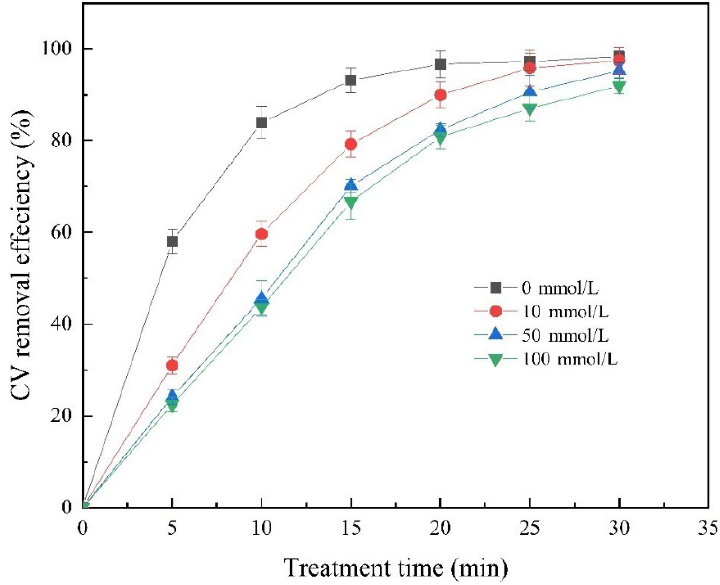
Figure 8. Free radical quenching experiments. (Initial CV concentration = 25 mg/L, discharge voltage = 22 kV, frequency = 50 Hz, aeration O 2 = 3.0 L/min, red mud dosage = 2.0 g, conductivity = 26 μs/cm).